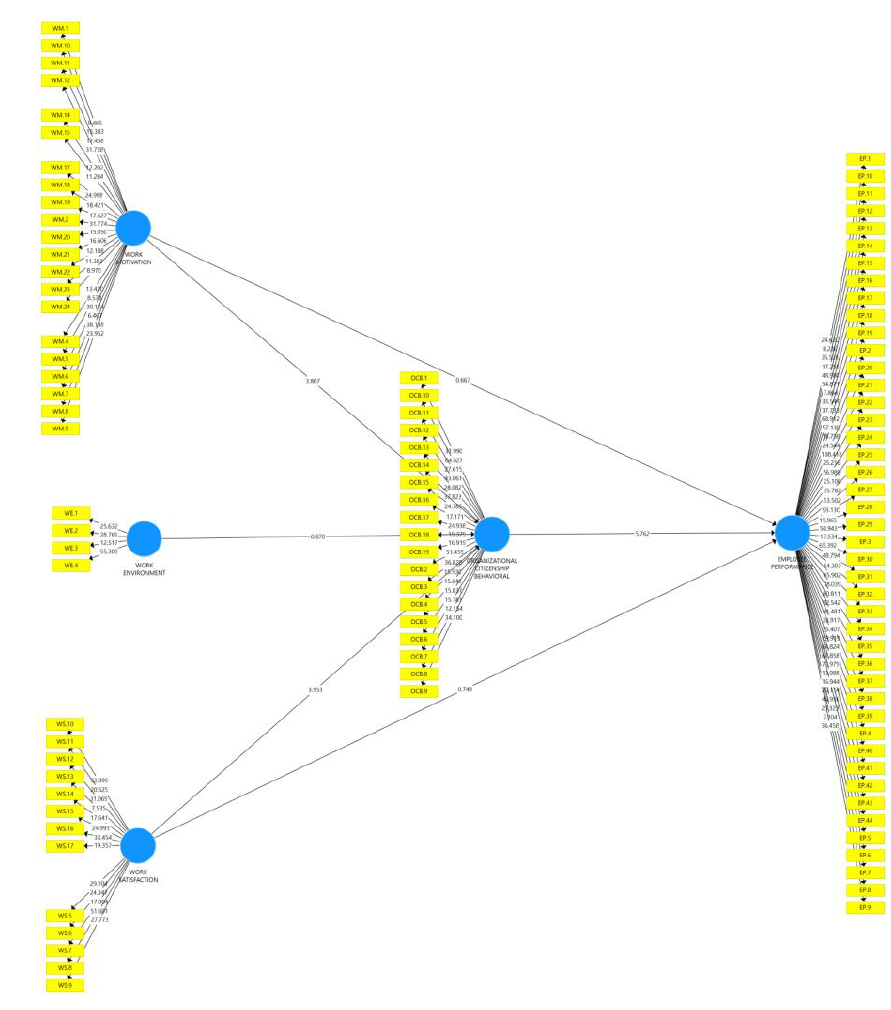
Figure 2: Structural Model